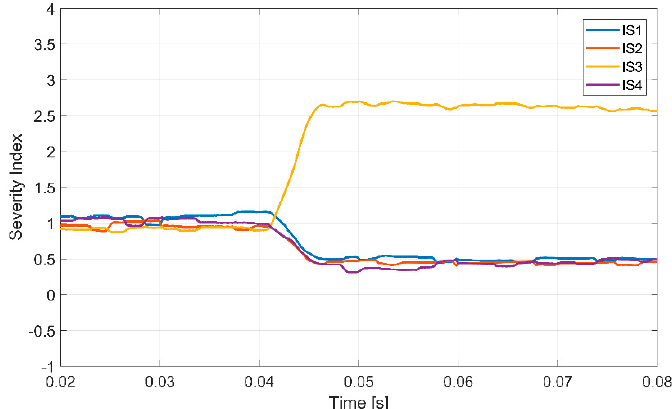
Figure 23. Diagnostic variables associated with the motor winding currents of the SRM at 600 rpm in normal operation and short-circuit failure of power device S 1 C (experimental result).